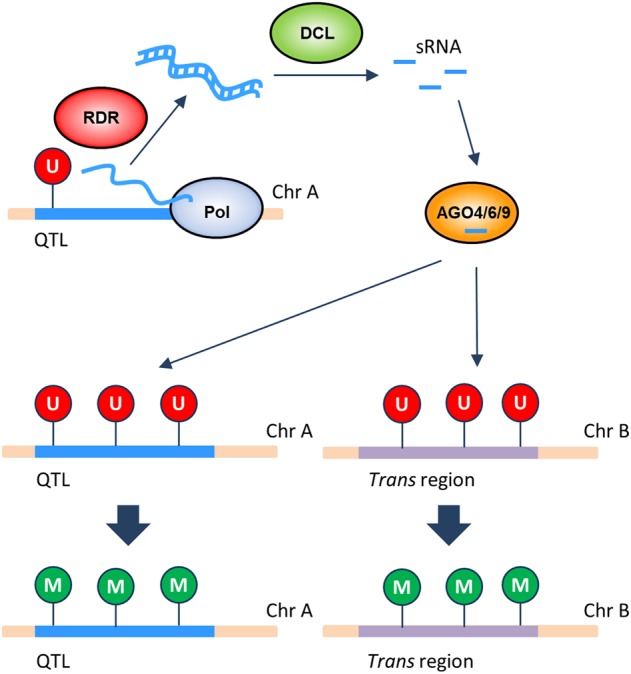
Theoretical model for the regulation of DNA methylation by differential targeting of sRNA to loci in trans. Changes in DNA methylation can be induced directly by differential recruitment of components of the RdDM pathway, or indirectly by post-transcriptional silencing of genes. (DCL) Dicer, (M) methylated, (Pol) RNA polymerase, (RDR) RNA-dependent RNA polymerase, (U) unmethylated.